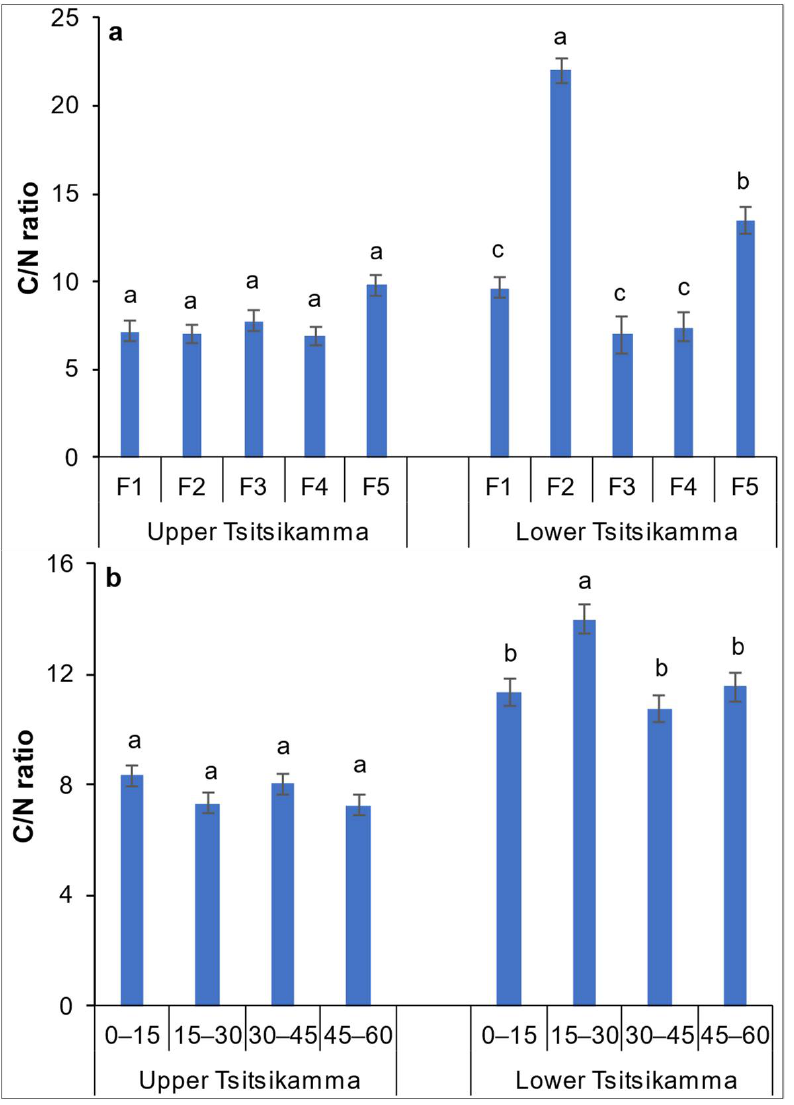
Figure 5. Effects of different farm management ( a ) and soil depth ( b ) on C/N ratio under mixed pastures in the Tsitsikamma dairy farms. Error bars indicate standard error of means. Different letters per site indicate significant difference. C, carbon; N, nitrogen.